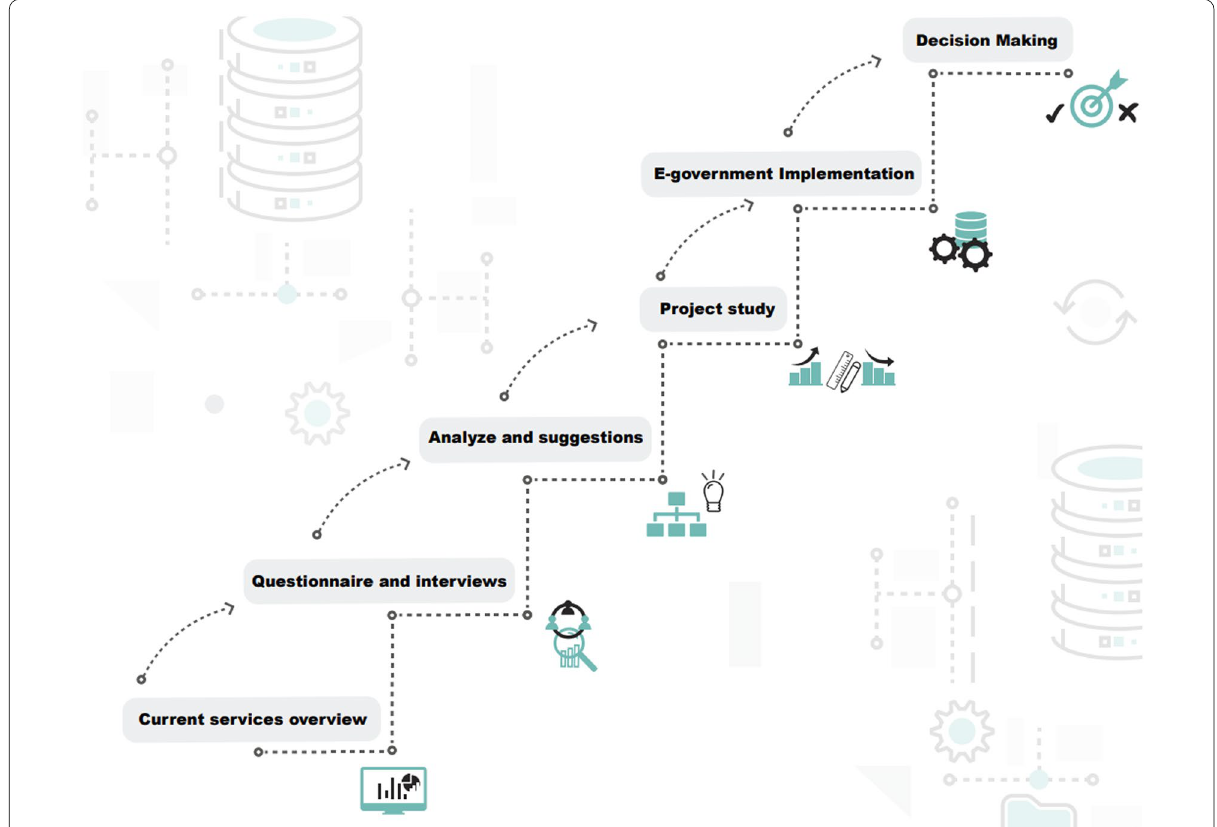
Fig. 7 Implementation of e-government for logistical health